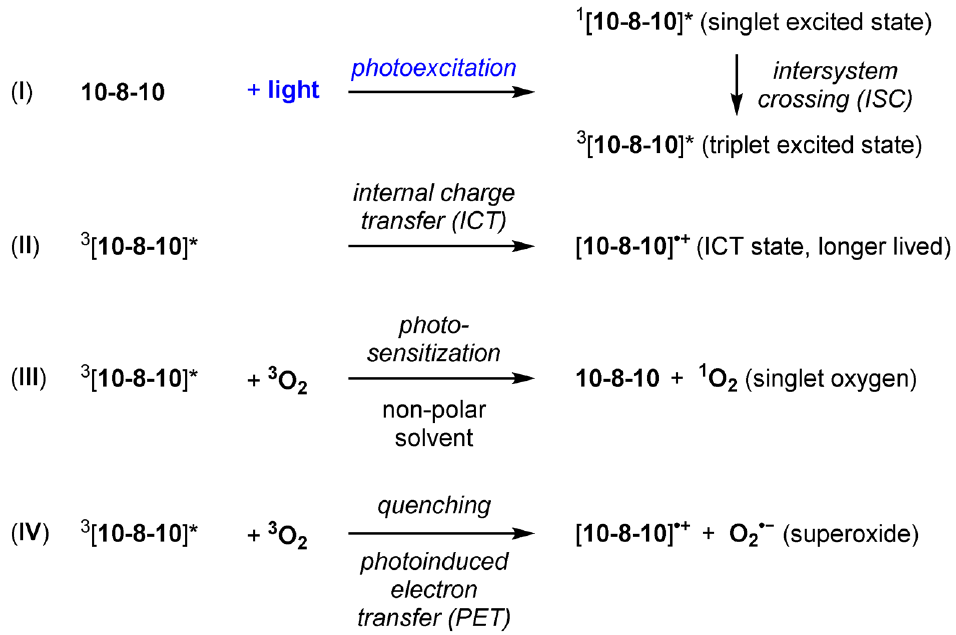
Figure 2. Proposed 10-8-10 Dimer photoexcitation events (I,II) and promoted reactions to generate oxidants (III,IV).